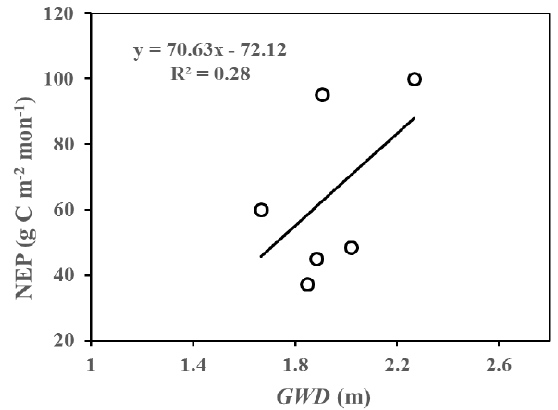
Figure 9. The relationship between net ecosystem productivity (NEP) and groundwater depth (GWD) in July and August across three years (2014–2016) at the study site.